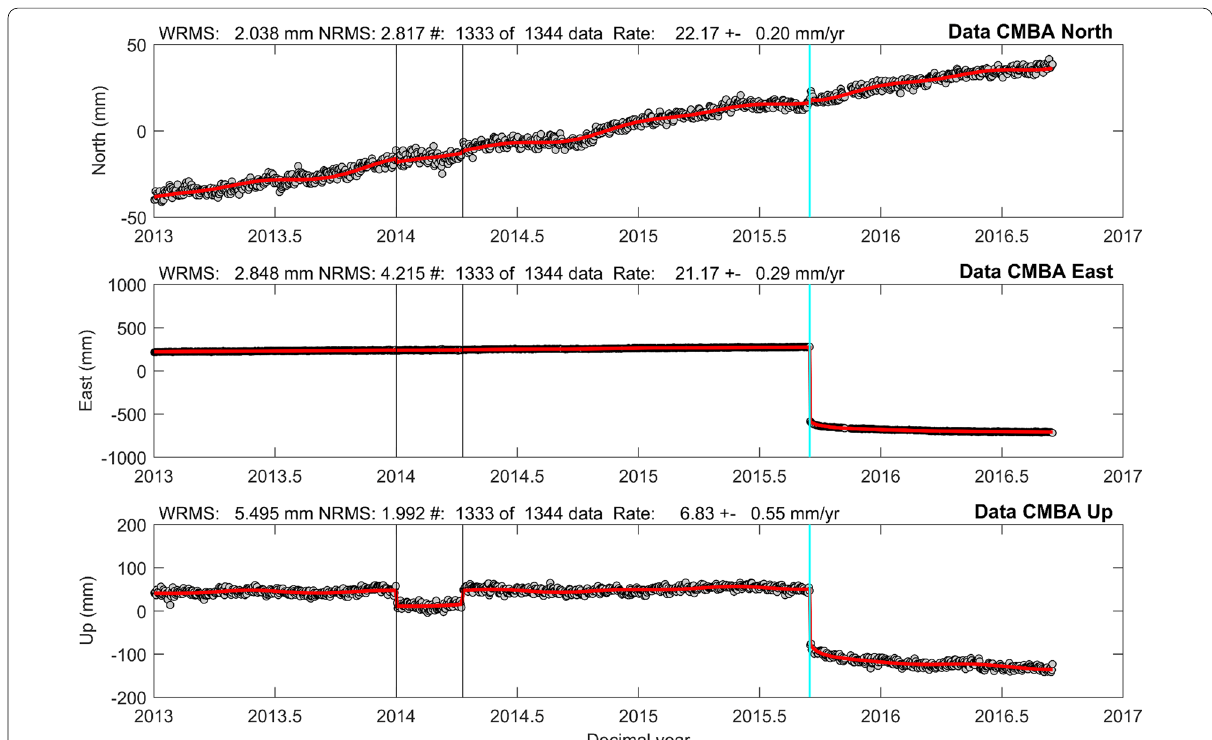
Fig. 2 GNSS position time series of site CMBA and corresponding modeled